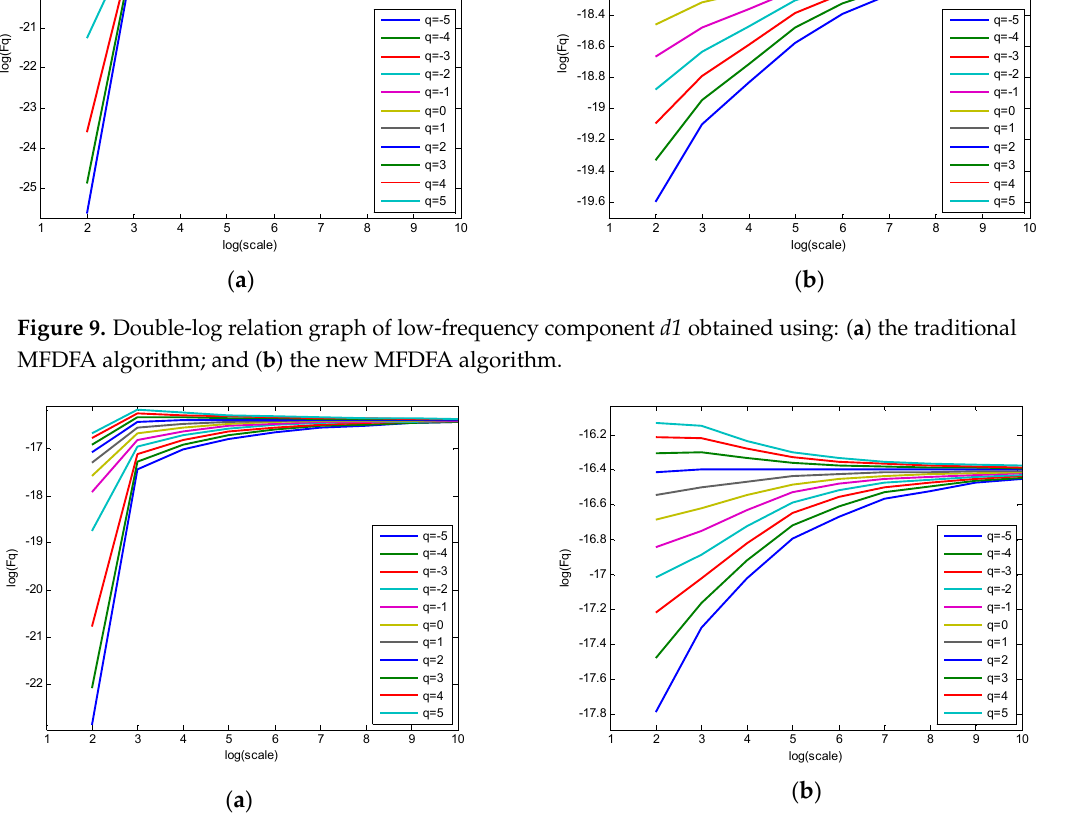
Figure 10. Double-log relation graph of low-frequency component d2 obtained using: ( a ) the traditional MFDFA algorithm; and ( b ) the new MFDFA algorithm.